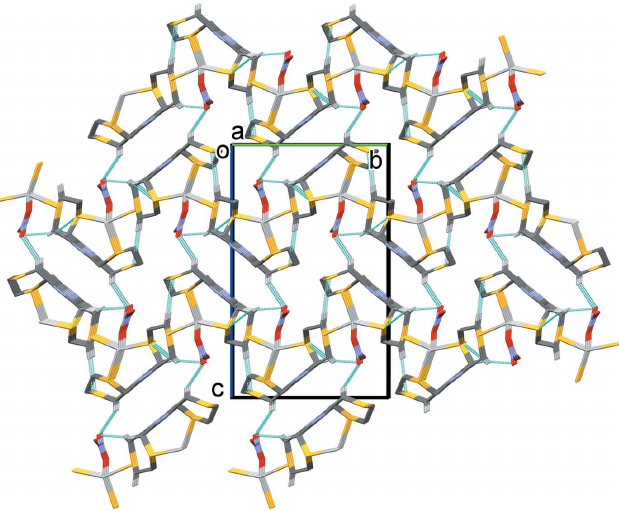
Figure 10 Aview along the a axis of the crystal packing of complex II . The hydrogen bonds are shown as dashed lines (Table 4). For clarity, only the H atoms involved in these interactions have been included.